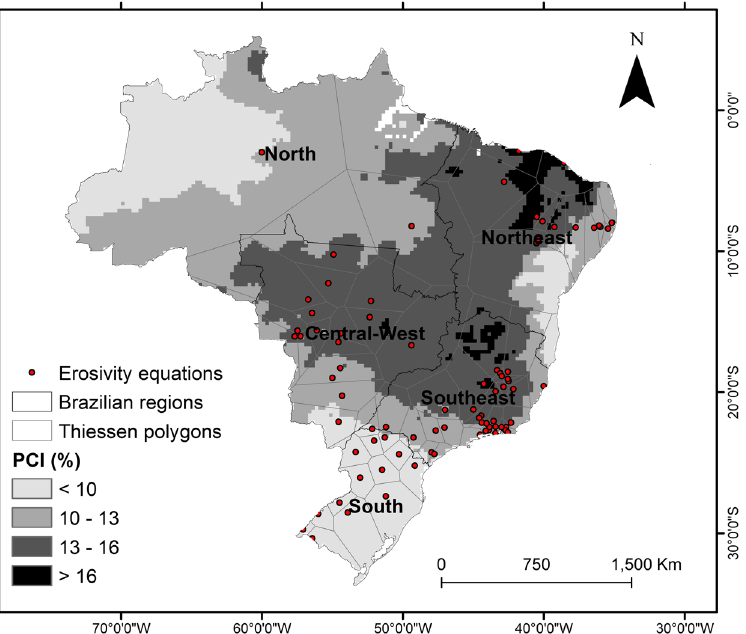
Figure 5. Methodology used to apply the rainfall data to the erosivity index equation. Shades of gray represents the classes of the Precipitation Concentration Index. Light gray lines are the area of influence of each equation. Red points represent the location of development of the erosivity index equations developed in Brazil. Map created with ESRI ArcGIS 10.1